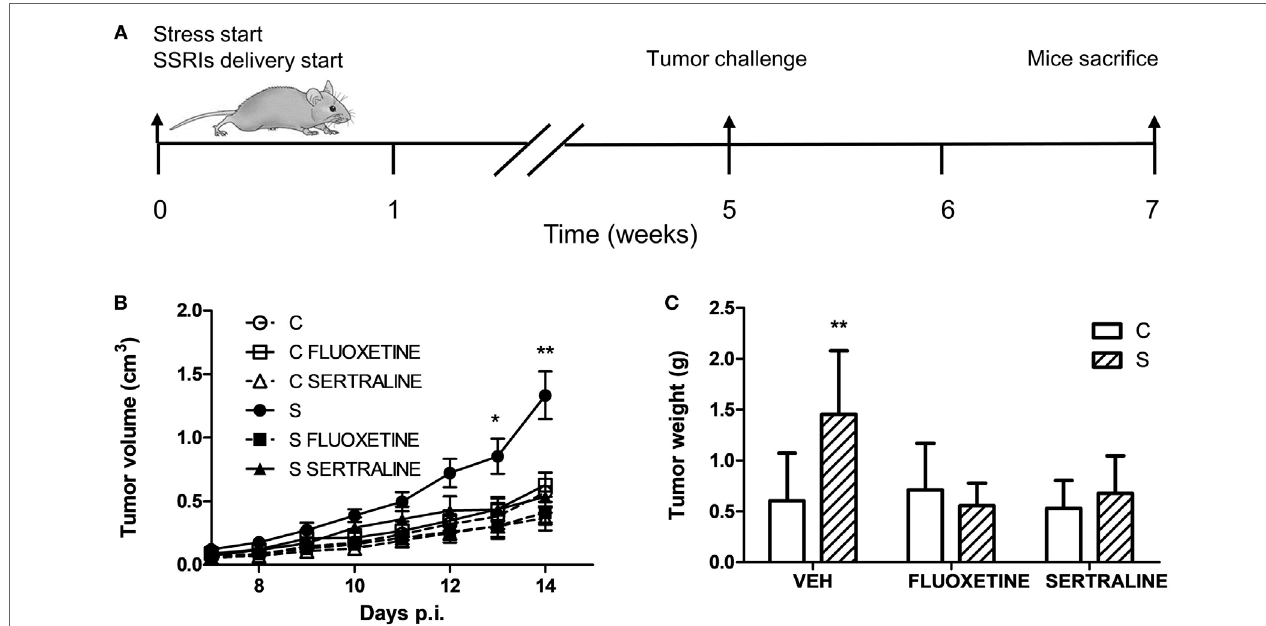
FigUre 1 | Effect of fluoxetine and sertraline on stress-induced tumor progression. (a) Schematic representation of experimental protocol. C57BL/6J mice were treated either with (S) or without (C) the chronic stress protocol, and with or without (VEH) fluoxetine or sertraline. Five weeks later, 3 × 10 6 EL4 cells were subcutaneously injected to generate solid tumors. Two weeks post injection (p.i.), mice were sacrificed. (B) Time course of tumor volume for the different experimental groups. (c) Tumor weight at day 14 post EL4 cells injection. Values are expressed as mean ± SEM. n = 6 mice per group. * p < 0.05; ** p < 0.01 respect to control